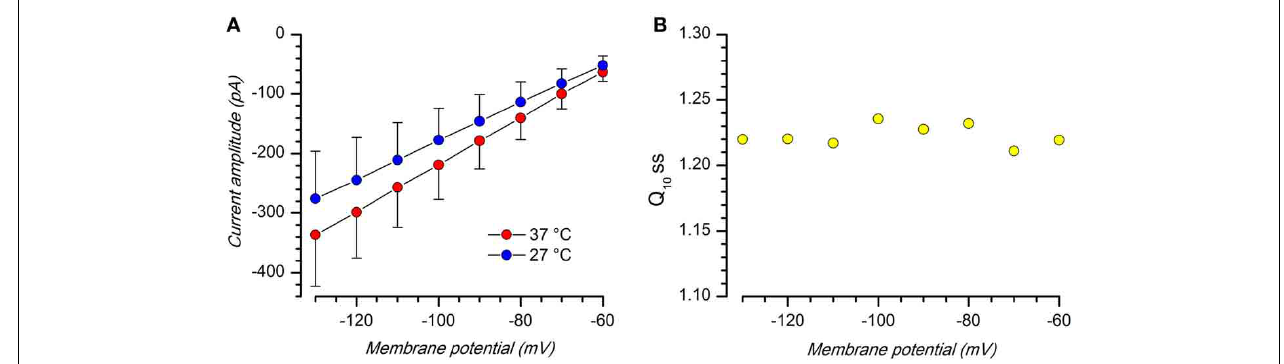
FIGURE 6 | Effect of temperature. (A) Comparison of K ir current amplitude (Iss) at 27 and 37 ◦ C; EC2 solution with BL1 and BL2; n = 8. (B) Q10 at the different voltages; the mean value is 1.22 ± 0.003; n =